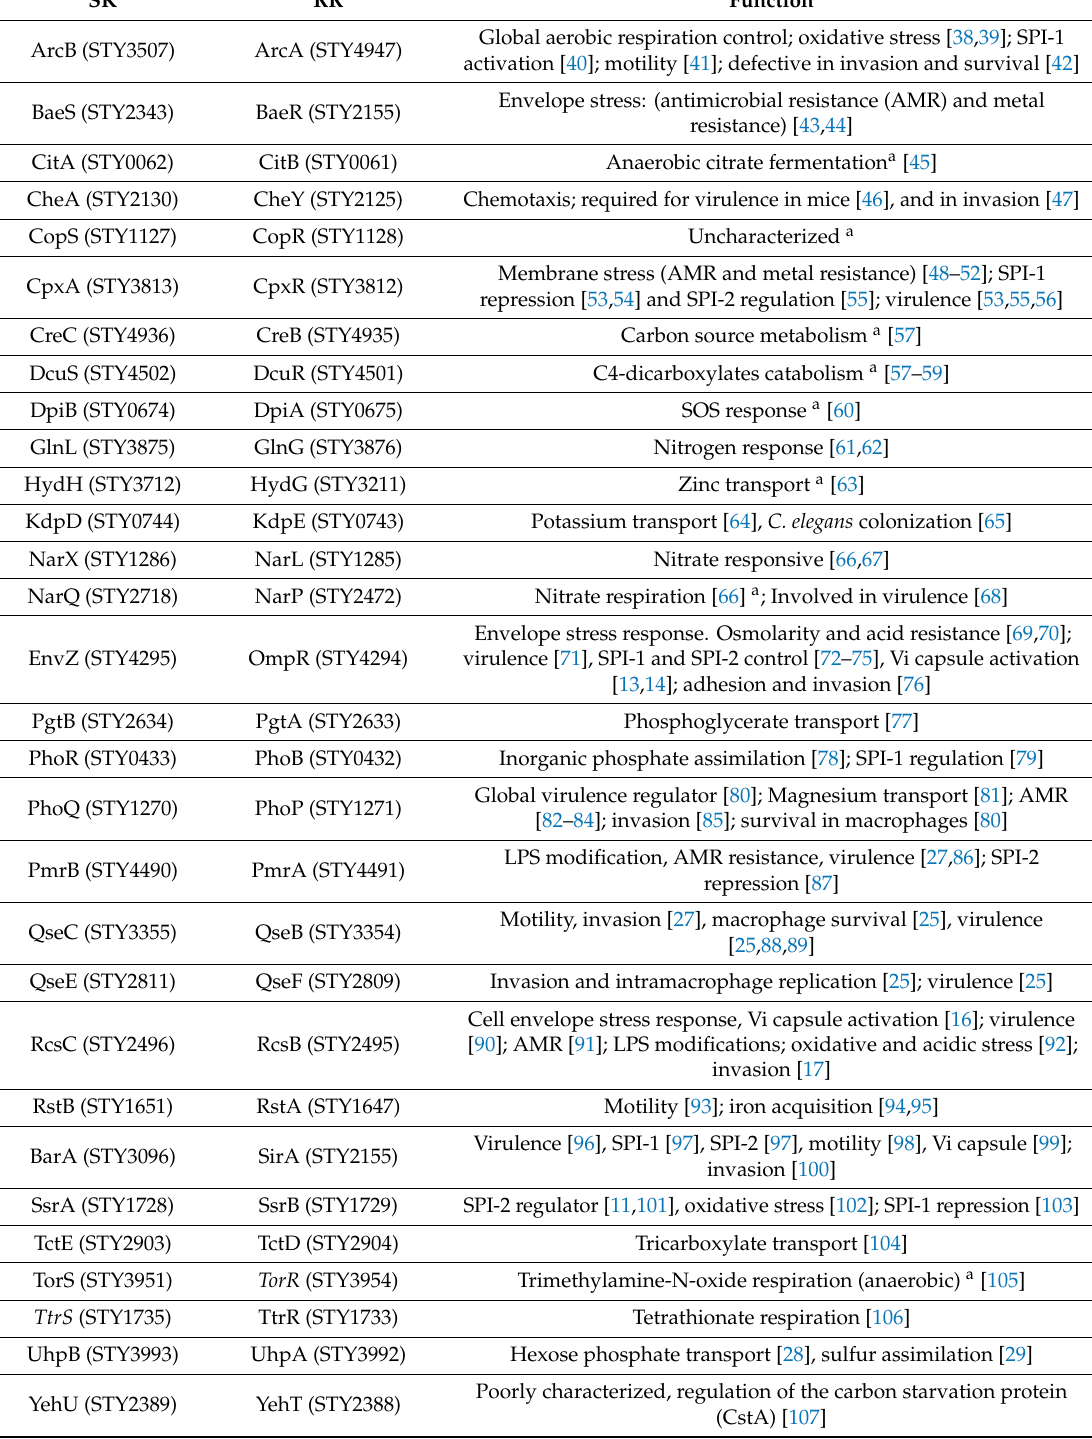
Table 1. Two-component systems of Salmonella Typhi and their putative